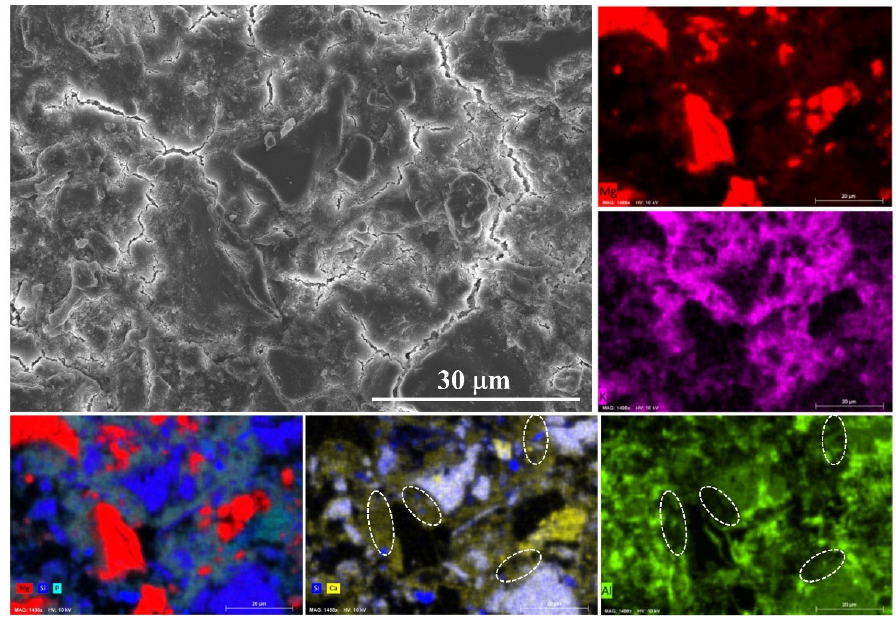
Figure 7. Typical SEM image and EDS mapping result of sample P ‐ 40%OS at 28 days.